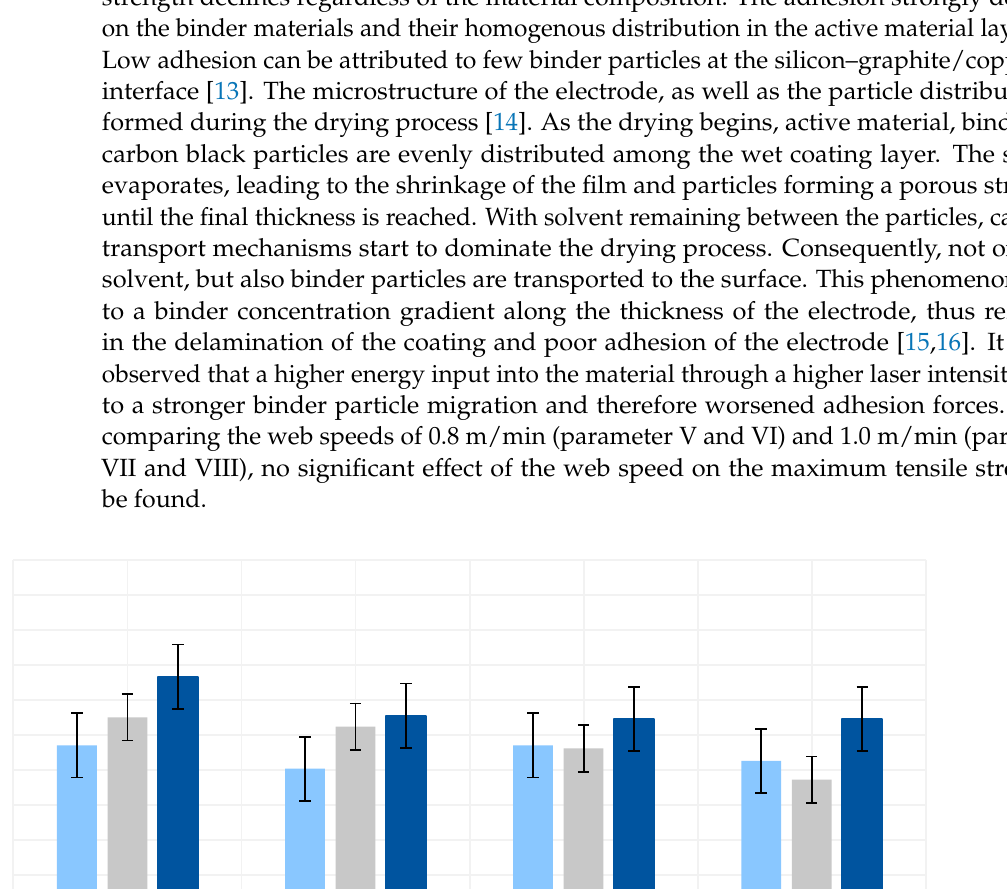
Figure 6. Residual moisture of convection- and laser-dried anodes with 10 w solid -% silicon content. It can be obtained that all samples exhibit a residual moisture between 3.7% and 5.2%. Anodes exposed to a lower energy input during drying do not show a significant larger moisture content in comparison to electrodes dried with a higher heating temperature or